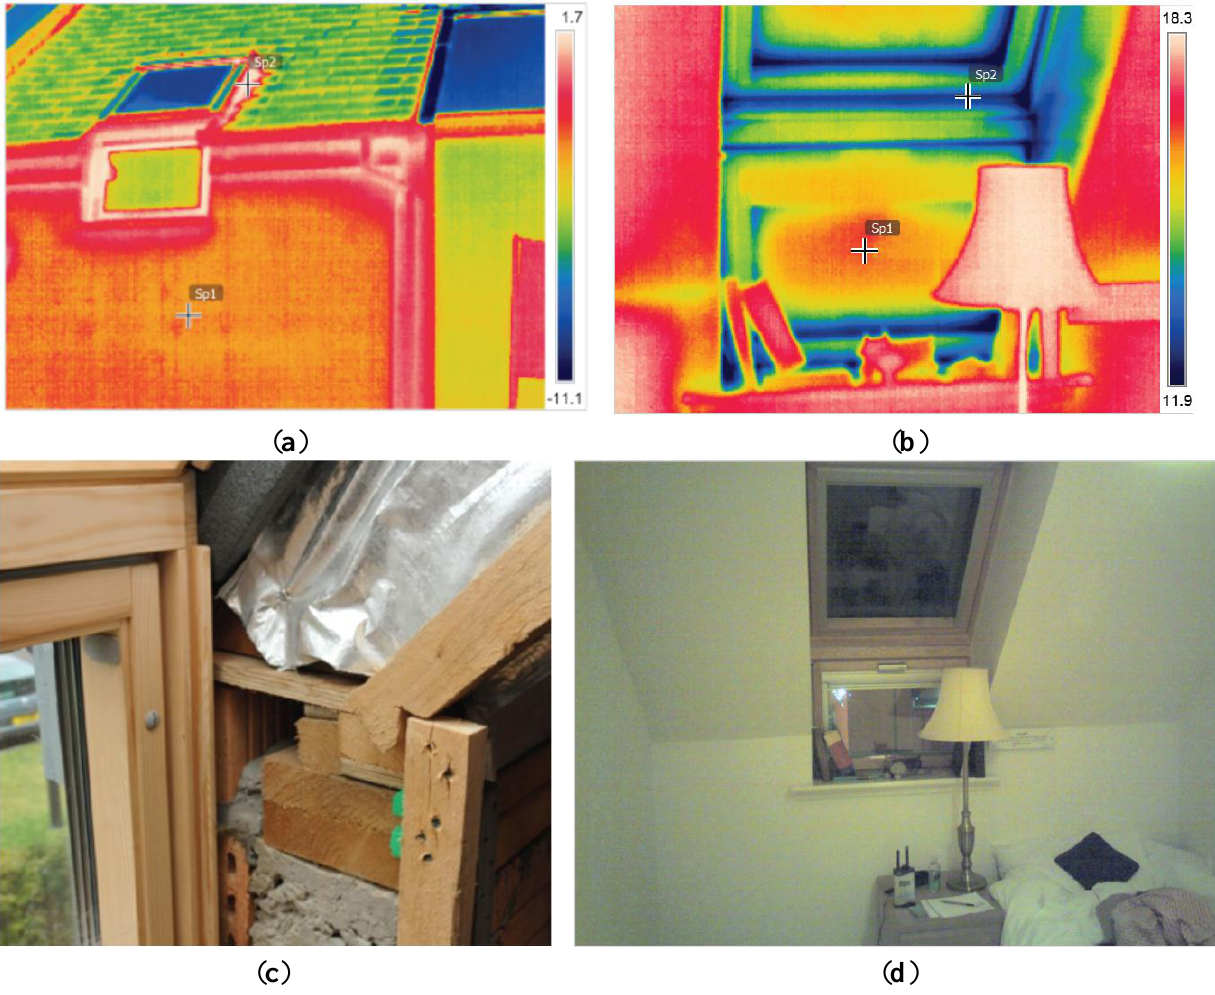
Figure 5. Thermal weaknesses at window openings. ( a ) Dormer window external thermographic image; ( b ) Dormer window internal thermographic image; ( c ) Construction of the dormer detail; ( d ) Internal view of finished dormer window.